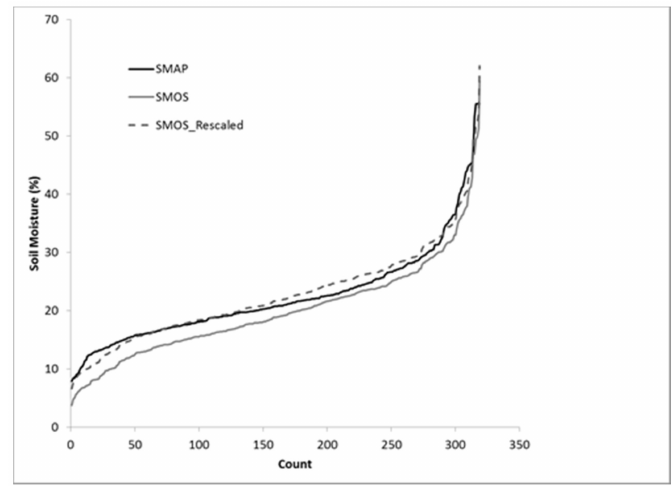
Figure 2. Cumulative distribution functions for soil moisture from SMOS and SMAP and SMOS rescaled to SMAP statistical